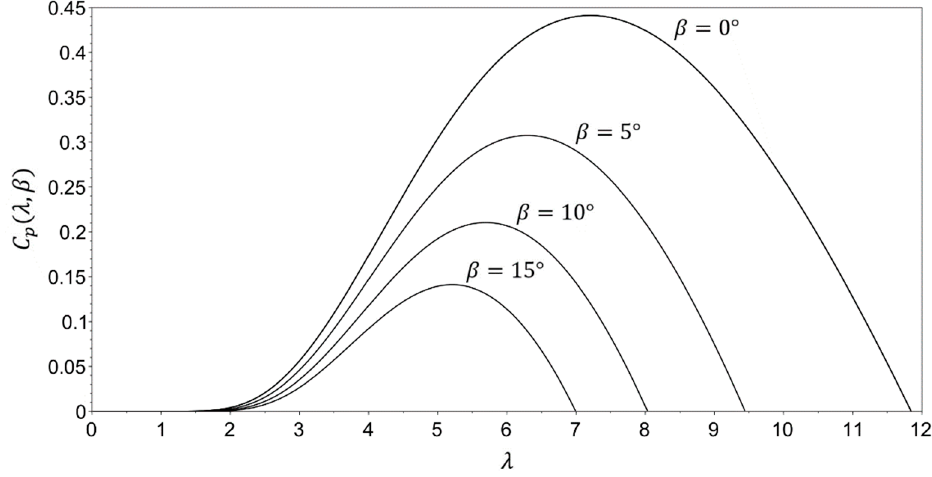
ffi cient curves as a function of tip-speed ratio and blade pitch Figure 1. Power coefficient curves as a function of tip-speed ratio and blade pitch angle. Figure 1. Power coe